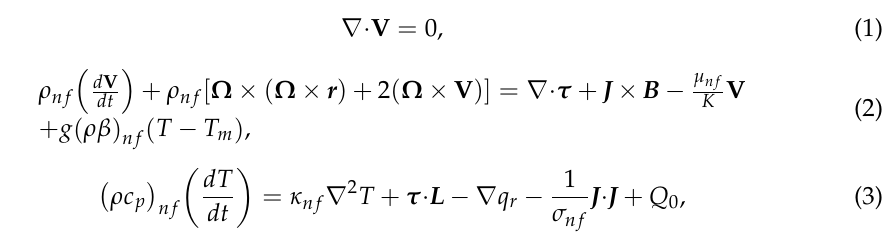
Figure 1. Schematic diagram of the problem. For incompressible flow, the mass, momentum and energy equations are